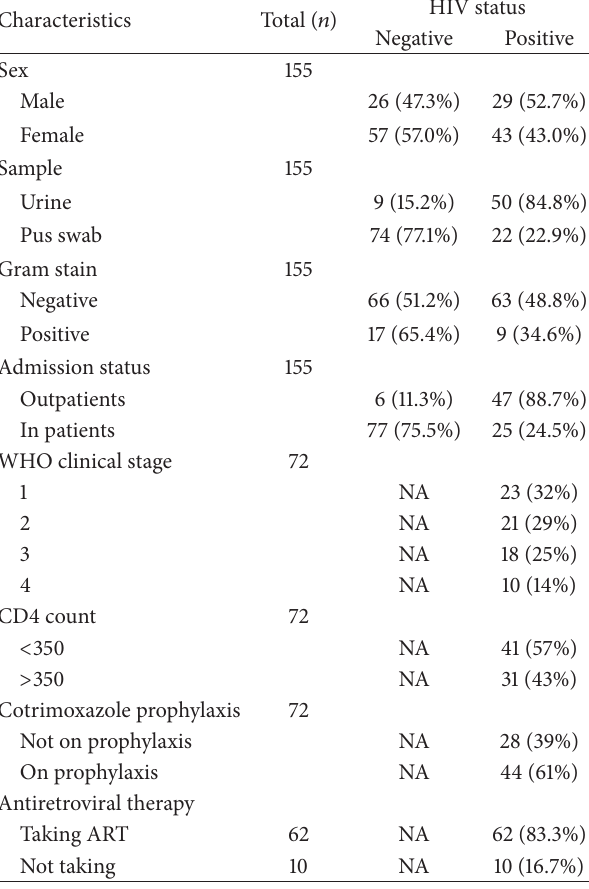
Figure 1: Study flow chart.